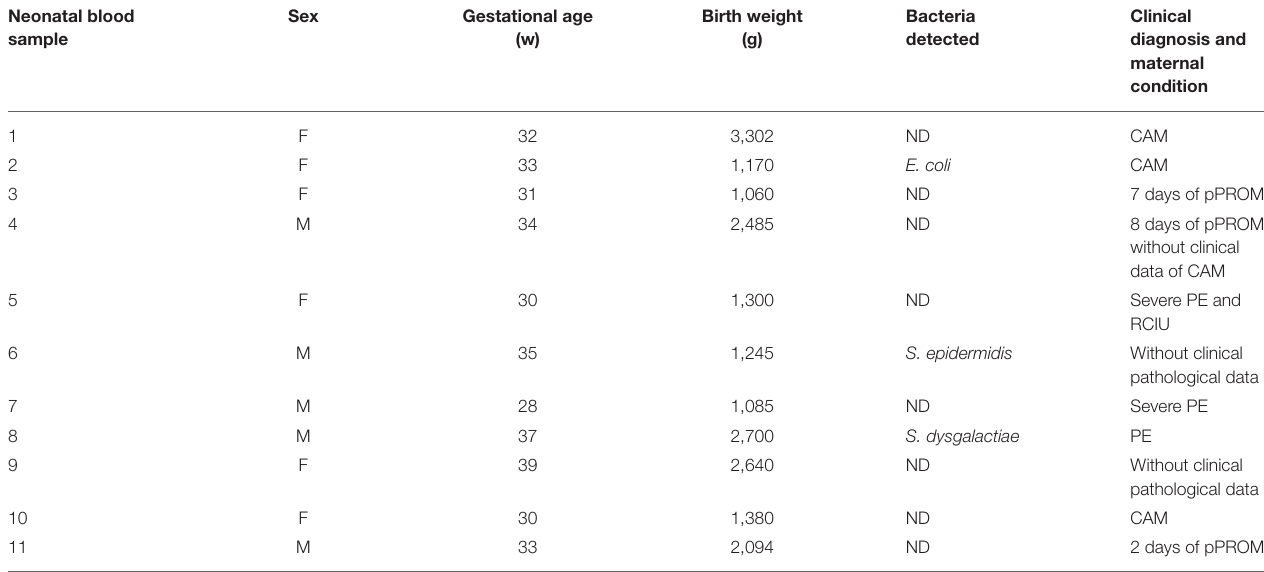
TABLE 2 | Clinical diagnosis of early-onset neonatal sepsis with bacterial detections. Neonatal blood Sex Bacteria sample